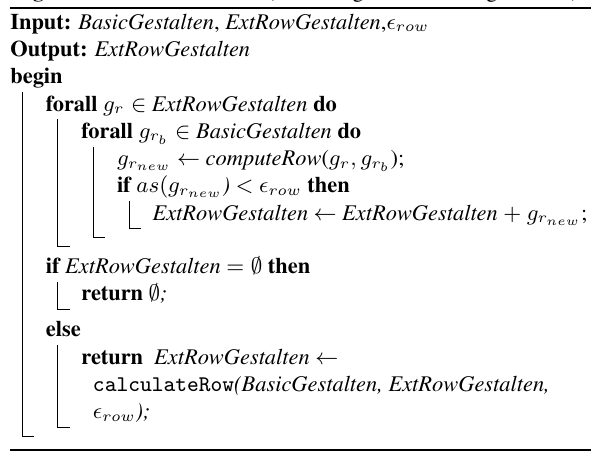
Algorithm 4: recursiveGestalting (Recursive search for